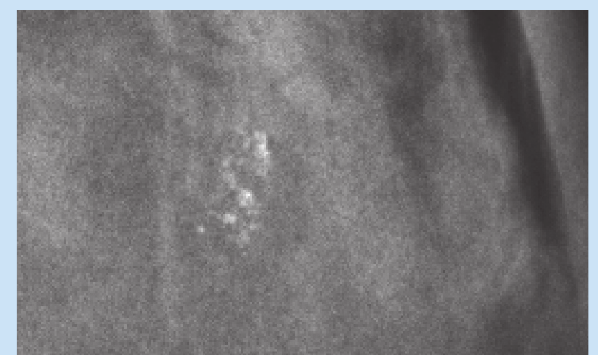
Fig. 1. Patient 1 – cluster of pleomorphic and amorphic calcifications; calcification pattern is malignant.